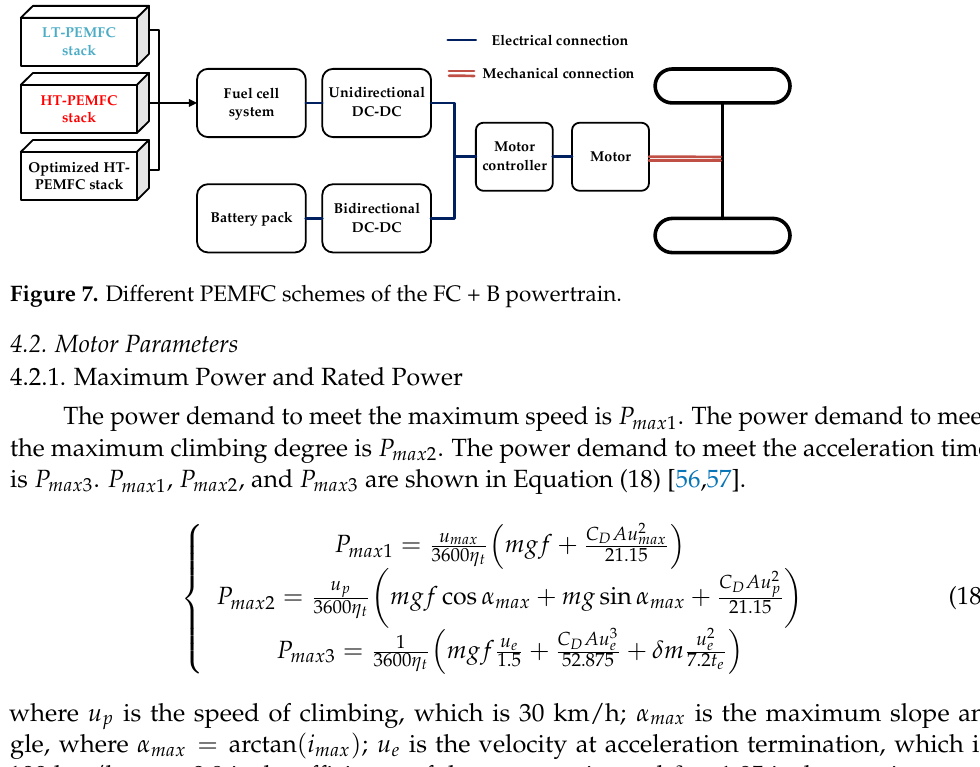
10 of 17 Table 1. Vehicle parameters and design requirements. Vehicle Parameters